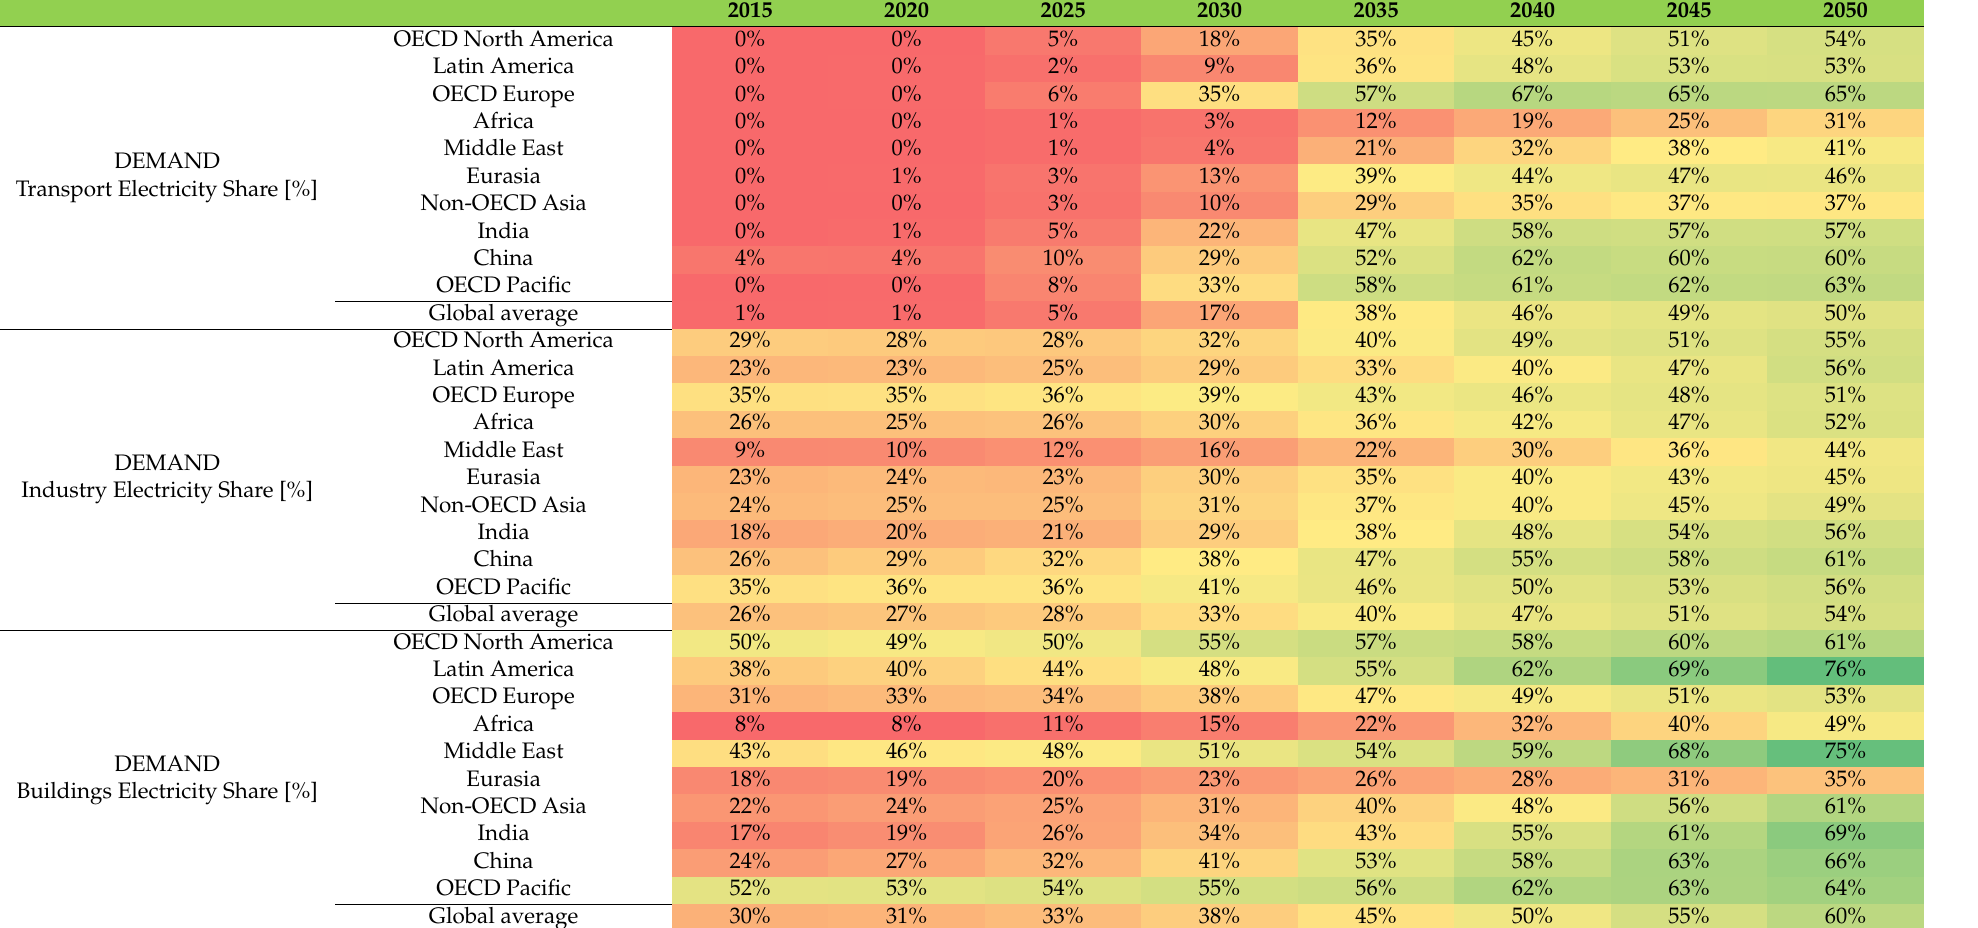
Table 2. Proportions of the final sectoral energy demands met by electricity under the 1.5 ◦ C Scenario. Colors indicate the different electrification shares where red is lower and green is